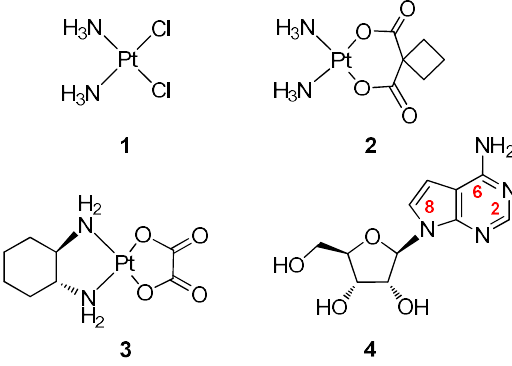
Figure 1. The structures of cisplatin ( 1 ), carboplatin ( 2 ) oxaliplatin ( 3 ) and tubercidin ( 4 ).